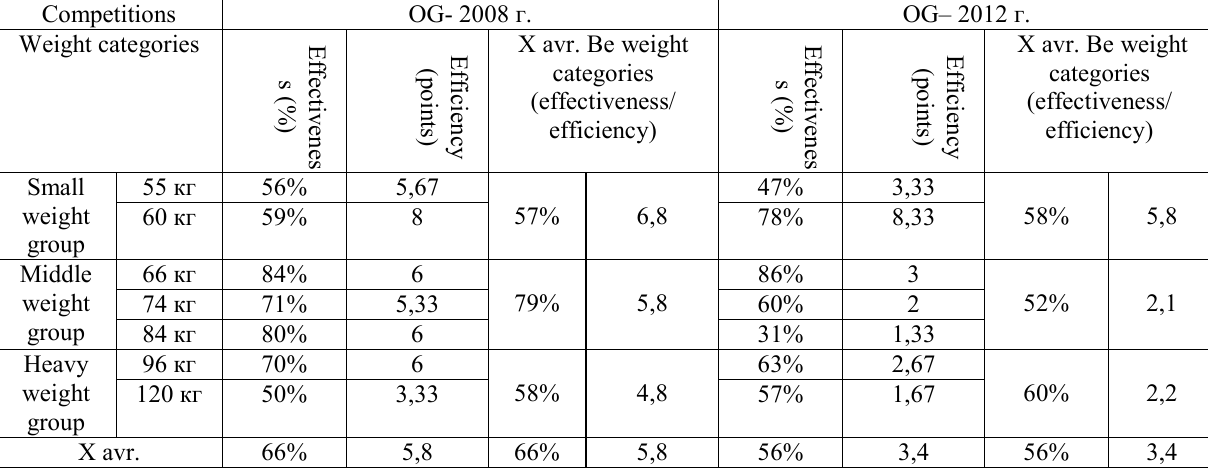
Effectiveness and efficiency of attacking actions of wrestlers-winners in final fights (for the 1 st and 3 rd places) Competitions OG- 2008